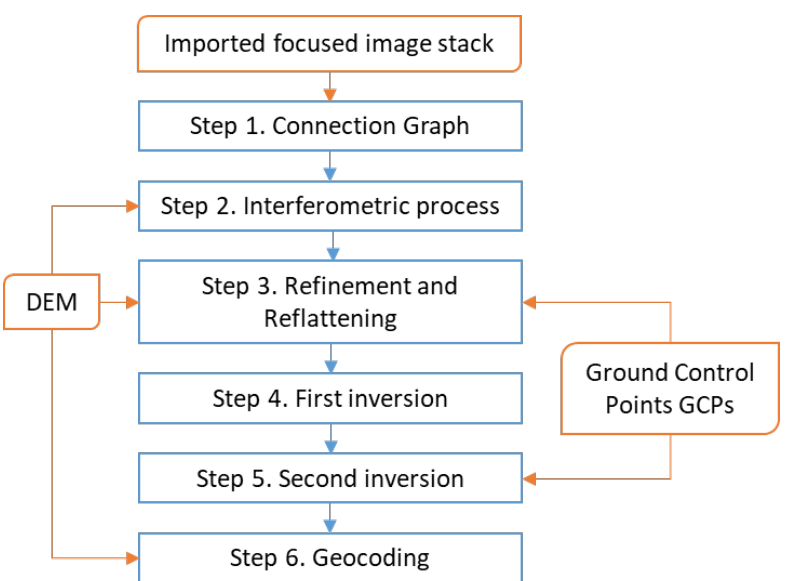
Figure 3. Small baseline subset (SBAS) processing workflow (SARscape v. 5.5.4).